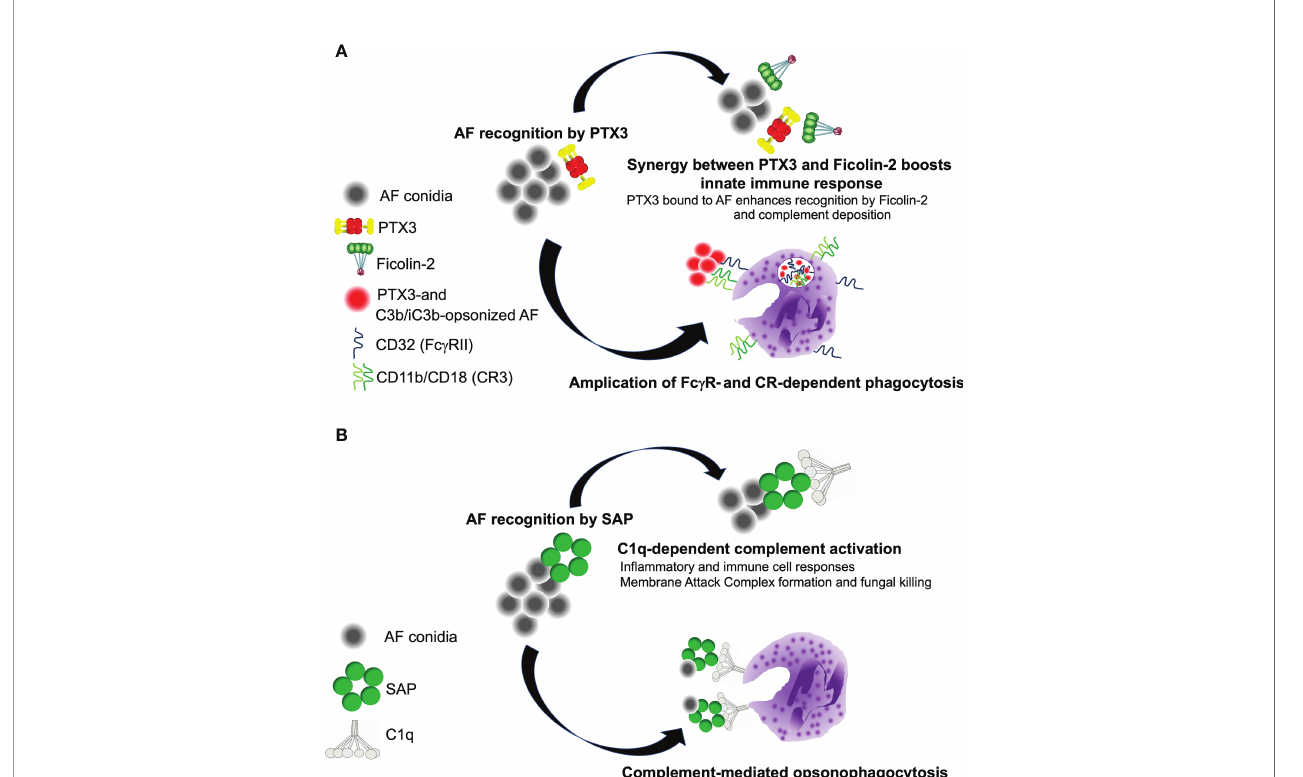
FIGURE 2 | Complement-dependent roles of PTX3 and SAP in the host resistance to A. fumigatus . (A) PTX3 and Ficolin-2 recruit each other onto AF conidia, and activate the LP. As C3b and iC3b deposit ( via the AP ampli fi cation loop), PTX3 promotes phagocytosis of AF via Fc g RII (CD32)-dependent redistribution of CD11b (that forms with CD18 the complement receptor 3, CR3, major receptor of iC3b) to the phagocytic cup. (B) SAP recruits C1q to AF conidia, and promotes CP activation. This leads to enhanced disposal of the pathogen through neutrophil-dependent phagocytosis and MAC-mediated